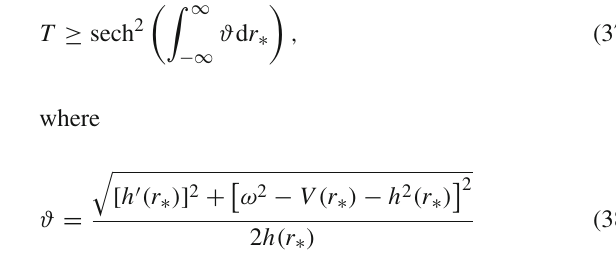
factor qualitatively. Then the influence of the potential form on the greybody factor can be explored. The rigorous